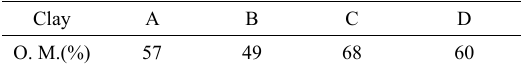
Table 3. Organic matter content (O.M.)